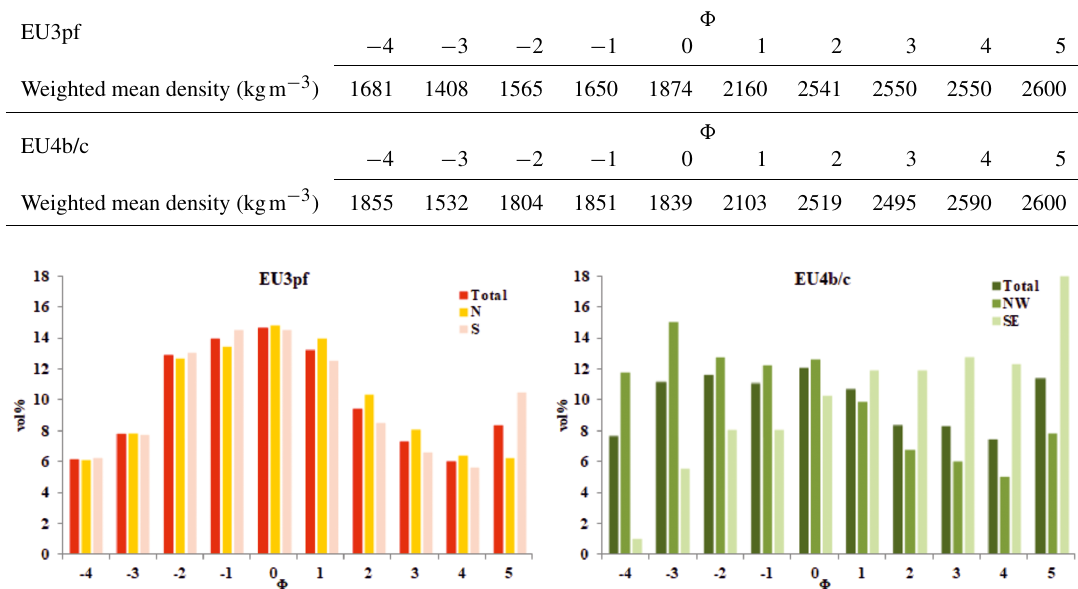
Table 2. Calculated mean densities for each grain size for both the EU3pf and EU4b/c units.